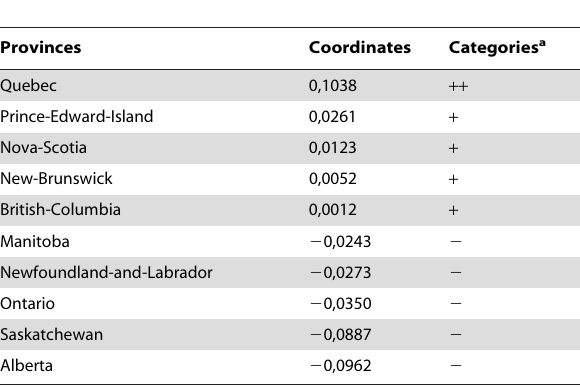
Table 4. Provinces’ coordinates on the Outdoor Index,